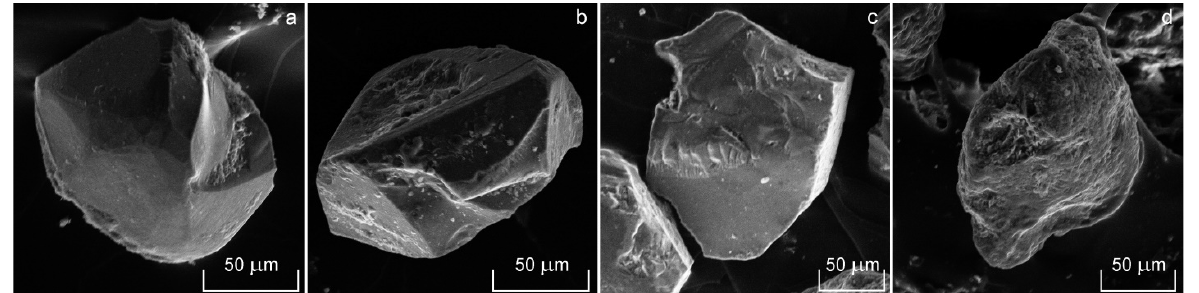
Figure 9. Morphology of chromian spinel grains from the Verkhne-Yaushevo paleoplacer (SE images): ( a )—slightly flattened octahedron with dodecahedron facets (group III), ( b )—fragment of truncated octahedral bipyramidal crystal (group IV), ( c )—fragment of crystal (group V), ( d )—xenomorphic corroded grain (group VI).